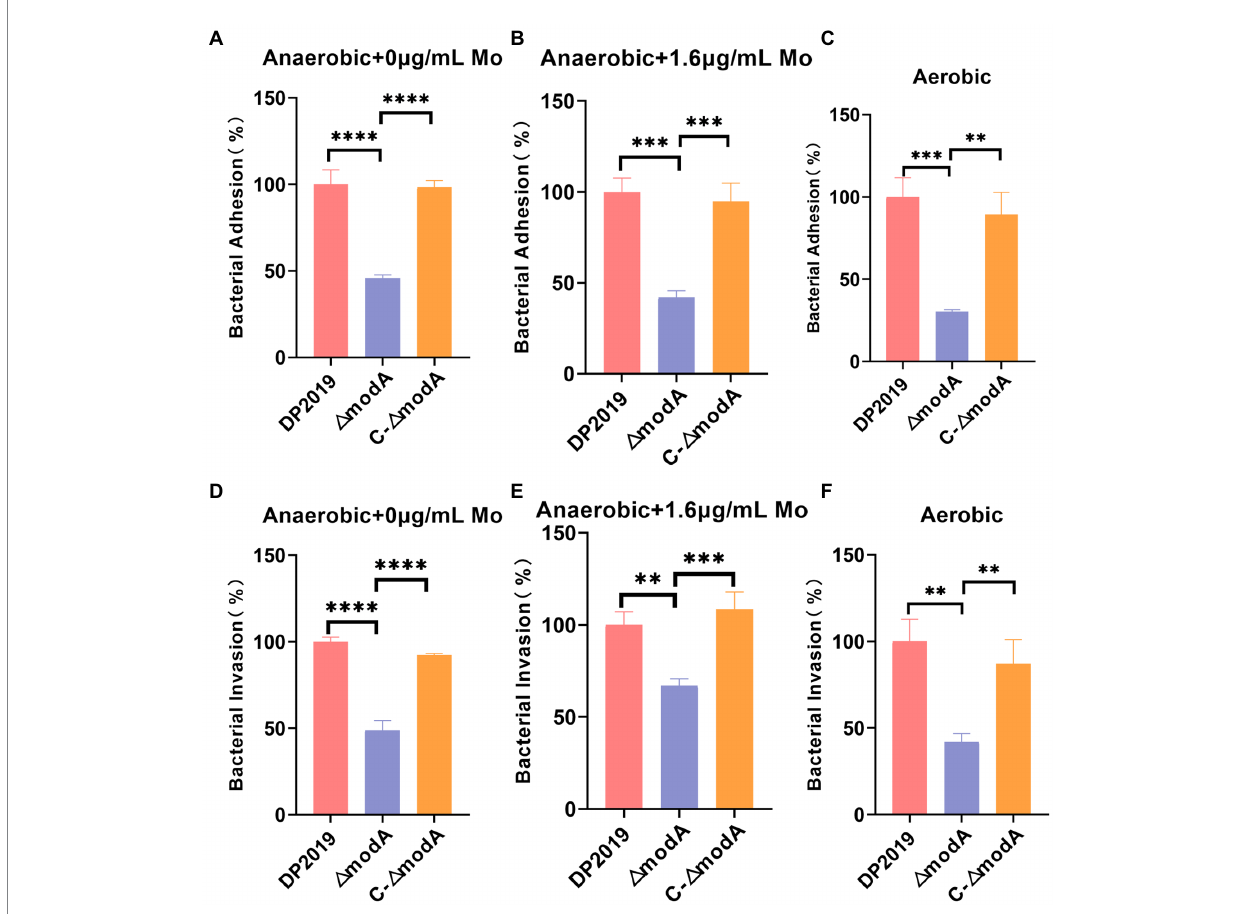
FIGURE 5 Effect of ModA on the virulence of P. mirabilis in vitro . (A) Adhesion to immortalized human bladder epithelium cells under anaerobic conditions was expressed as the percentage of adherent bacteria (CFU/mL) versus the total bacteria added (CFU/mL). Then DP2019 group was designated as 100% to calculate the relative rate of adhesion. (B) Adhesion to immortalized human bladder epithelium cells in 1.6 μ g/mL molybdate under the anaerobic conditions to avoid the interference of anaerobic growth defects on the results. (C) Adhesion to immortalized human bladder epithelium cells under aerobic conditions. (D) Invasion of immortalized human bladder epithelium cells under anaerobic conditions, which was expressed as the percentage of viable bacteria (CFU/mL) that survived the gentamicin treatment versus the total bacteria added (CFU/mL). Then DP2019 group was designated as 100% to calculate the relative rate of invasion. (E) Invasion to immortalized human bladder epithelium cells in 1.6 μ g/mL molybdate under the anaerobic condition to avoid the interference of anaerobic growth defects on the results. (F) Invasion to immortalize human bladder epithelium cells under aerobic conditions. Data are presented as the mean ± S.D. of three independent experiments, ** p < 0.1, *** p < 0.001, **** p <